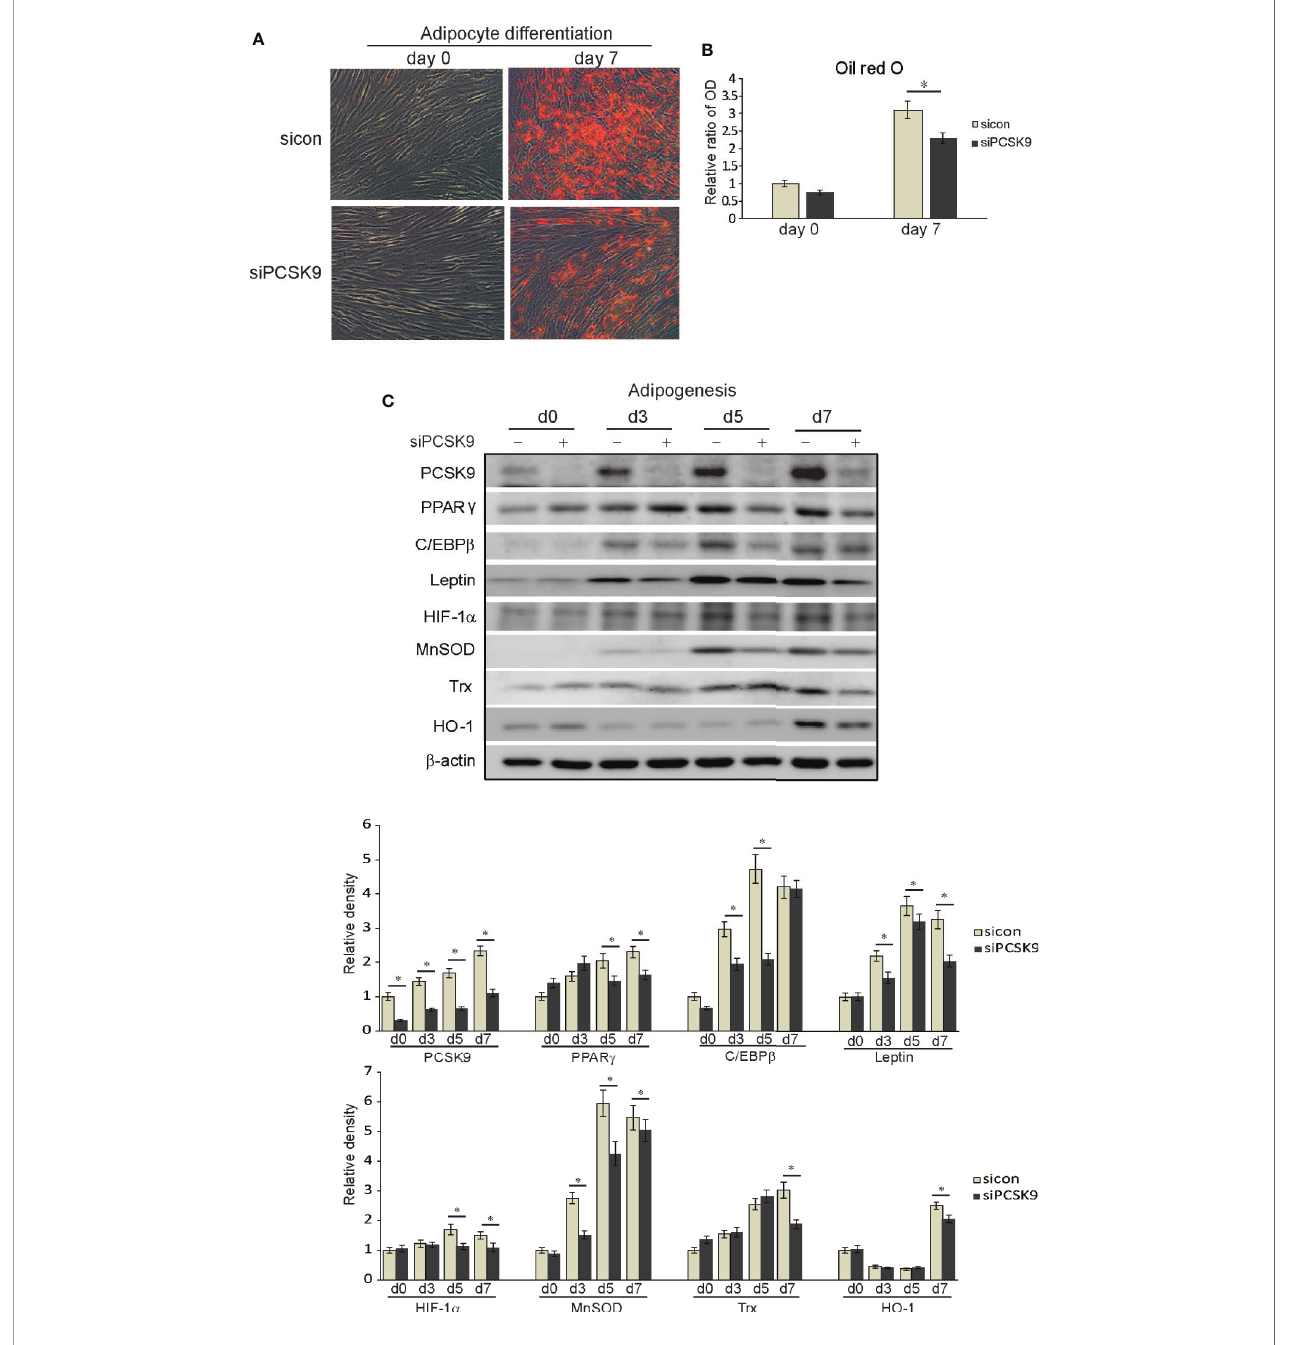
FIGURE 5 | Proprotein convertase subtilisin/kexin type 9 (PCSK9) siRNA suppresses adipogenesis and oxidative stress in Graves ’ orbitopathy (GO) fi broblasts. Orbital fi broblasts from GO (n=3) patients were cultured in adipogenic medium to induce differentiation into adipocytes for 7 days. (A) Oil red O staining showed treatment with PCSK9 siRNA (50 nM, 24 h) attenuated adipogenesis. (B) Quanti fi cation by measurements of optical density of cell lysates at 490nm echoed the histochemical results. The results are presented as the mean optical ratio ± SD (* p < 0.05 between sicon and siPCSK9). (C) Western blot analyses showed that throughout the 7-day period of adipogenesis, the cell lysates of fi broblasts collected at different time points showed a gradual increase in production of PCSK9, which was markedly decreased when PCSK9 siRNA (50 nM, 24 h) was treated. The levels of adipogenic transcription factors, peroxisome proliferator-activated receptor gamma (PPAR g ) and CCAAT/enhancer-binding protein b (C/EBP b ), were substantially curtailed in fi broblasts transfected with PCSK9 siRNA. The levels of mature adipocyte marker, leptin, were also signi fi cantly reduced in the PCSK9 siRNA-treated group. The levels of antioxidants, manganese superoxide dismutase (MnSOD), thioredoxin (Trx), and heme oxygenase-1 (HO-1), and oxidative stress-related protein, hypoxia-inducible factor 1 a (HIF-1 a ) were signi fi cantly decreased in the PCSK9 siRNA-transfected group. Data in the columns indicate the mean density ratio ± SD, normalized to the level of b -actin in the same sample, and representative gel images are shown (* p < 0.05 between sicon and siPCSK9 on days 0, 3, 5, and 7 of